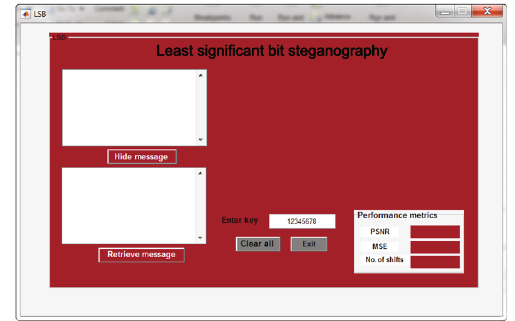
Figure 6: Interface of the extraction phase.